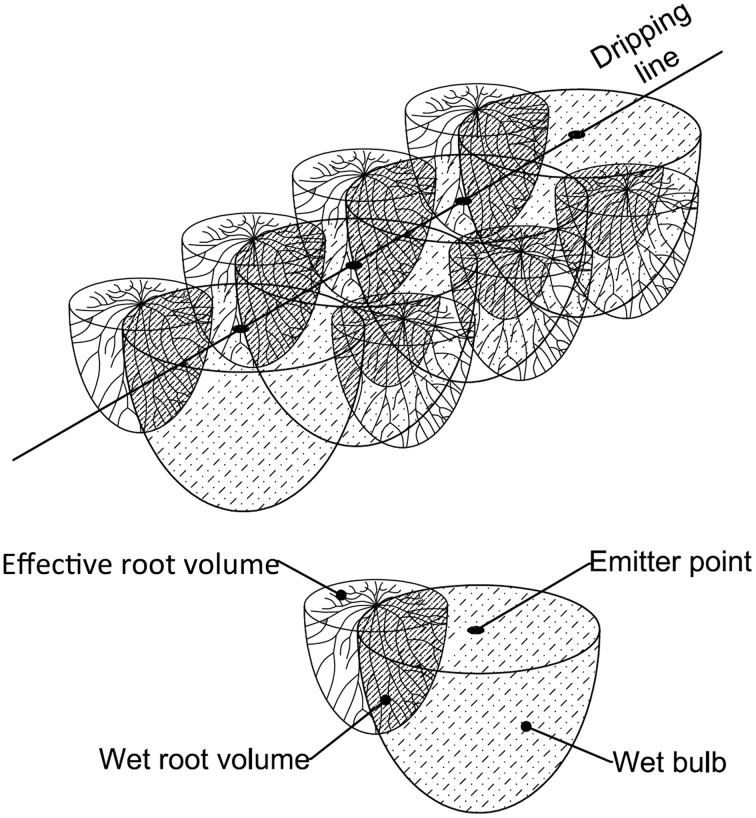
A three-dimensional representation of the physical model used by GesCoN to simulate the interaction between root apparatus and the wet soil volume under an emitter source point. The case refers to the interaction of a drip line with two twin rows.